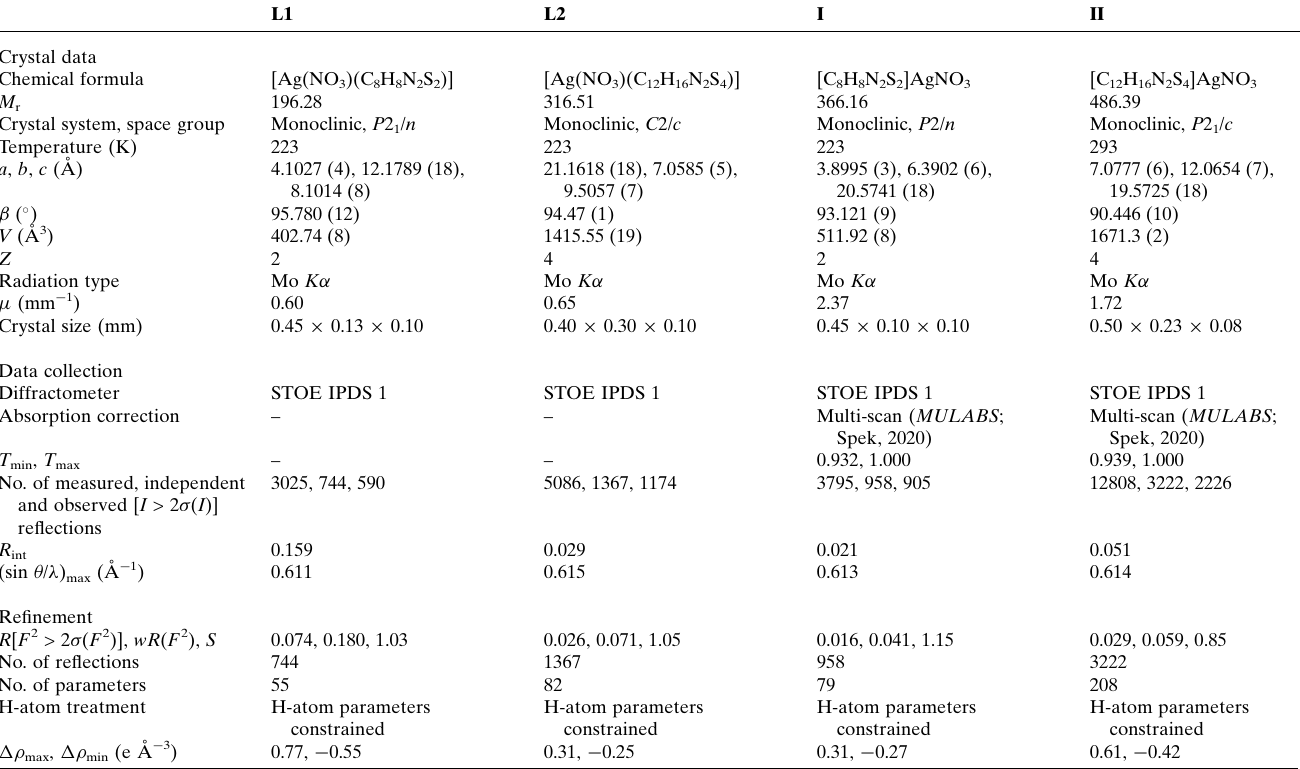
Table 6 Experimental details.